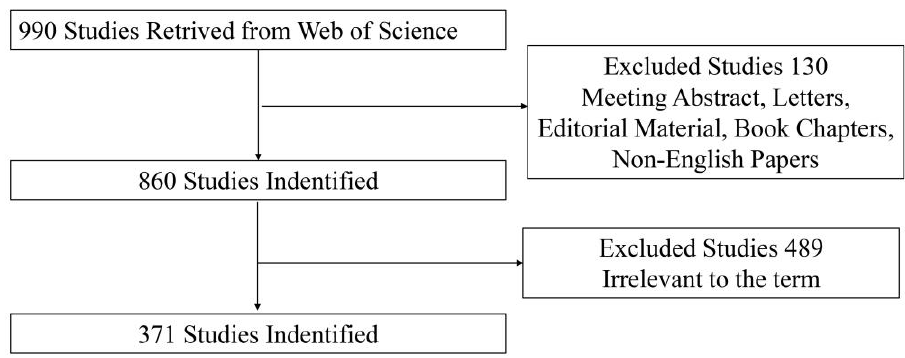
Figure 1. Flowchart of study inclusion criteria.